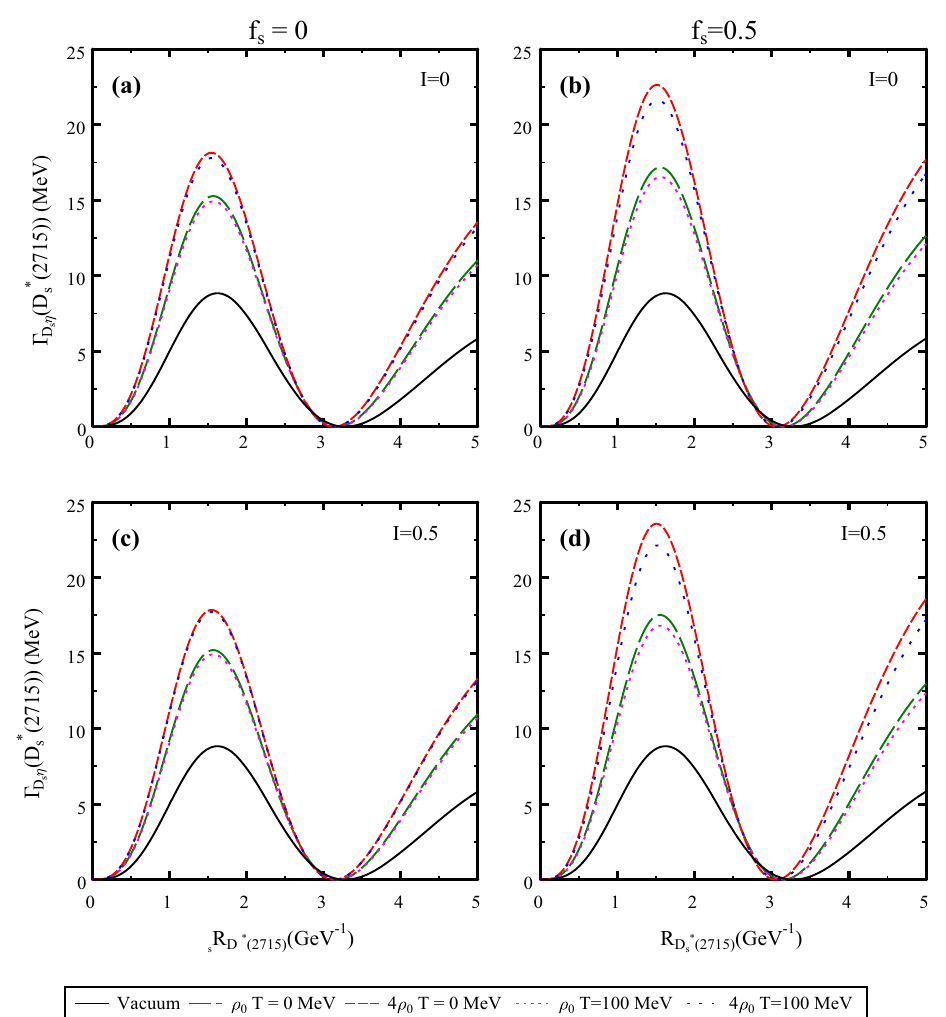
asymmetric parameters ( I = 0 and 0 . 5), temperatures ( T = 0 and 100) MeV and strangeness fractions ( f s = 0 and 0 . ( 2715 ) s